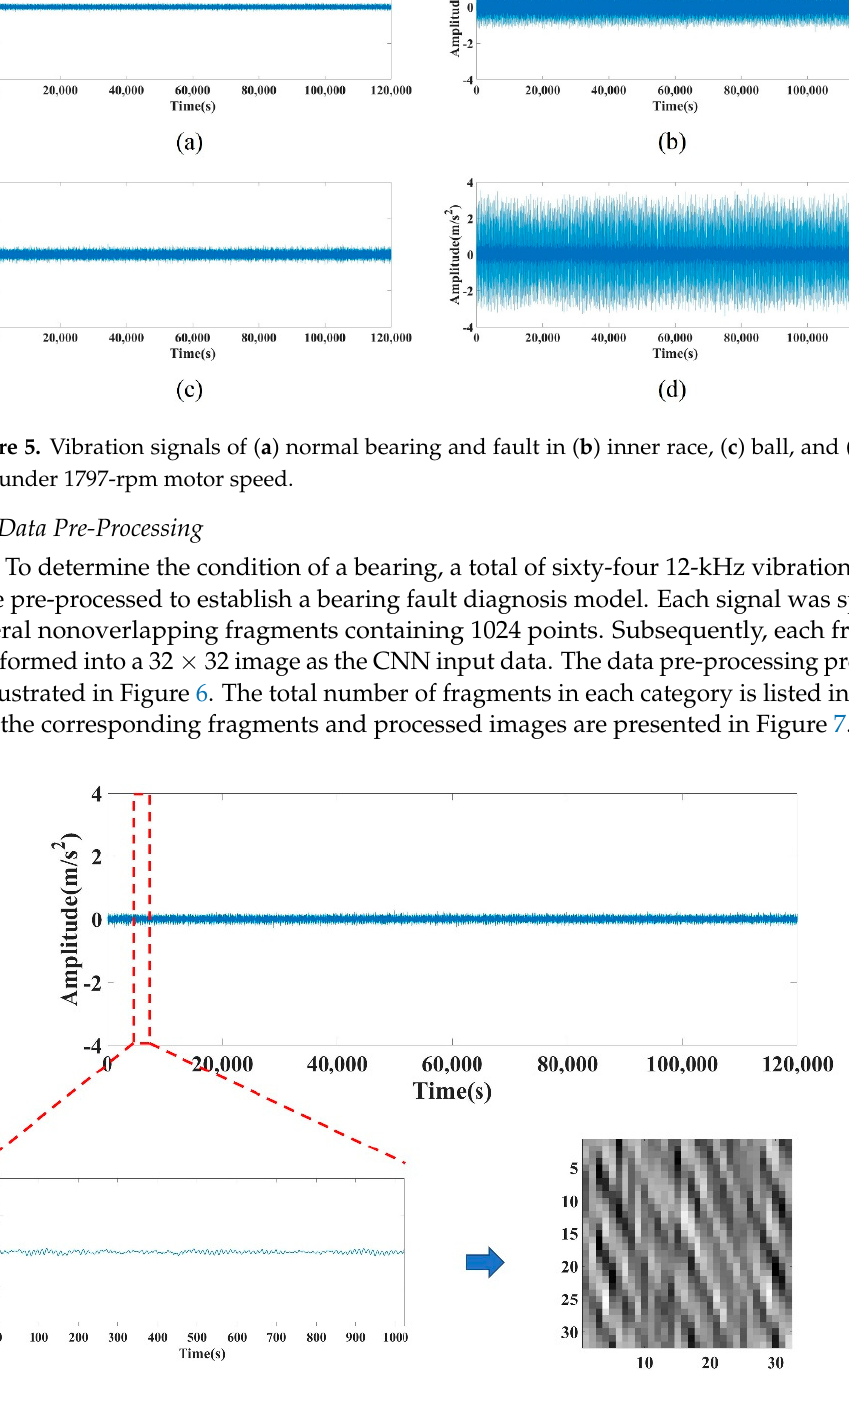
Figure 4. Apparatus used in Case Western Reserve University.